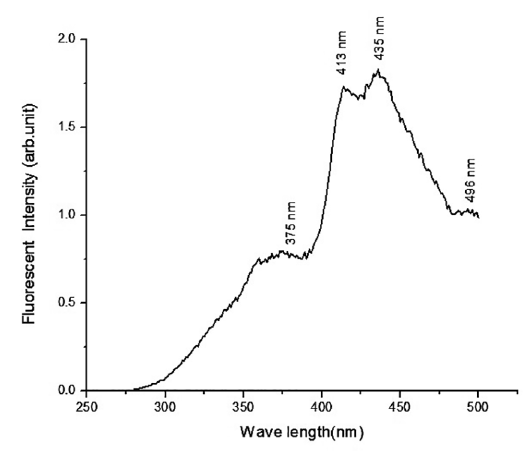
Figure 1: X-ray diffraction pattern of the Pr 0.5 %) doped borate glasses. wavelength etc. Figure 2 shows the excited spectrum of praseodymium doped borate glass . Weak features were displayed between 200 and 320 nm and single, strong band centered at 361 nm which indicates the lowest 4f-5d transition of Pr 3+ . In accordance with previous studies of Pr 3+ , it happened due to the charge transfer of Pr 3+ - O 2- transition at shorter wavelengths 18 .